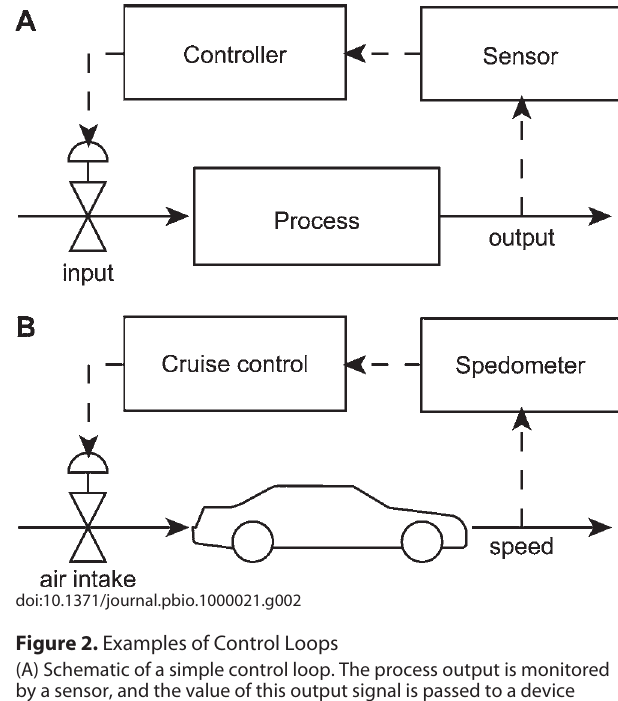
Figure 2. Examples of Control Loops (A) Schematic of a simple control loop. The process output is monitored by a sensor, and the value of this output signal is passed to a device called a controller. The controller calculates the difference between the output signal and the set point (the desired value of the output), and responds accordingly, often by physically manipulating an input parameter, such as a control valve. (B) Schematic of cruise control. The car is the process, and the car’s speed is the output. A speedometer sensor within the car tells the cruise control the car’s speed. The actuator on the cruise control then responds by opening or closing the throttle, allowing air intake into the